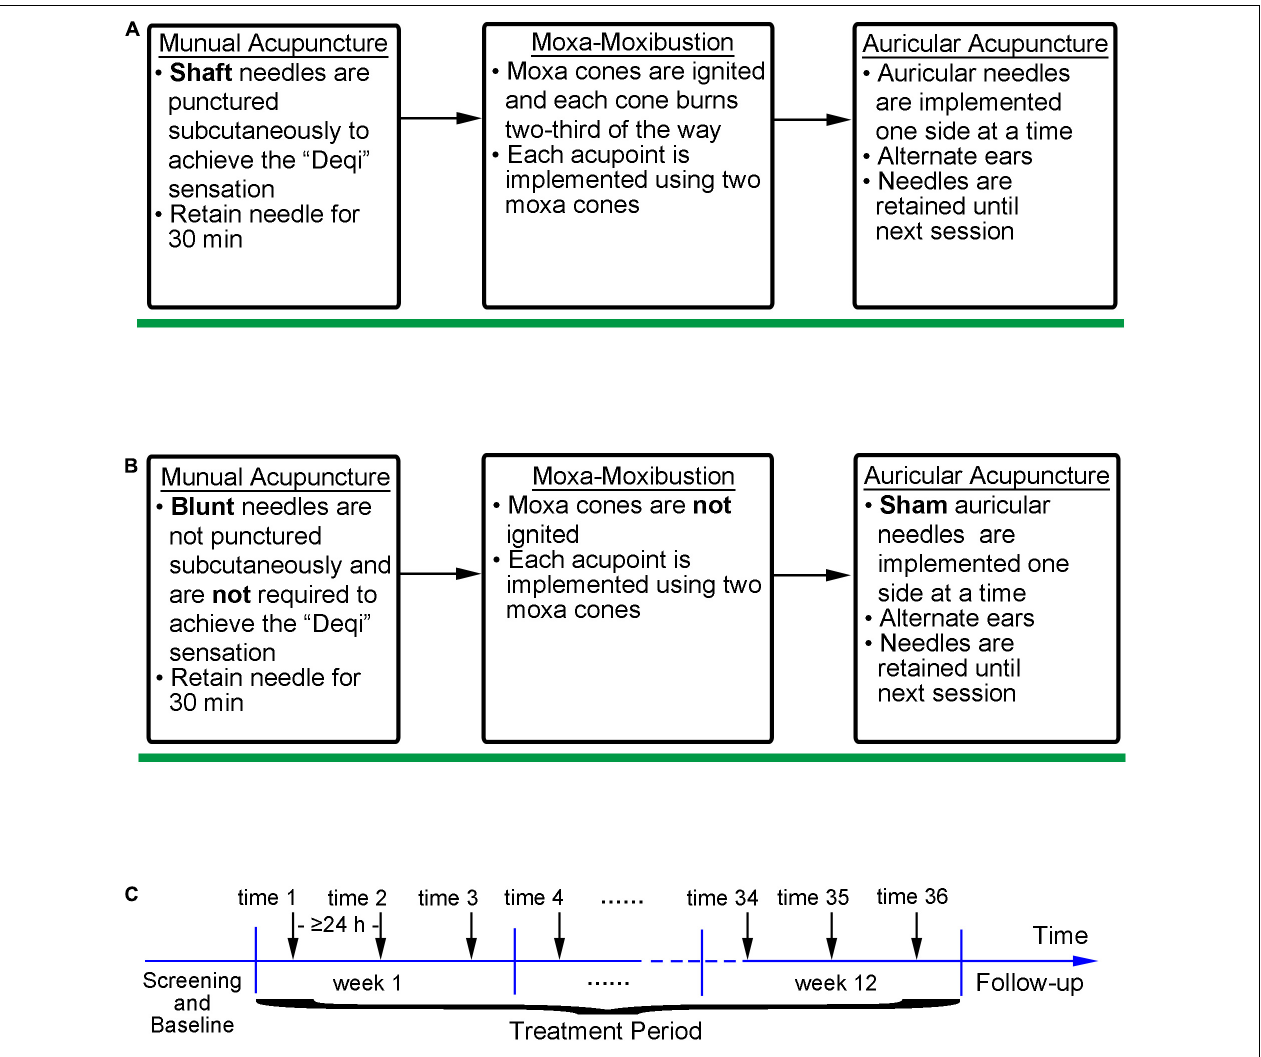
FIGURE 2 | The iAM implementation and intervention processes. (A) Implementation process of active iAM intervention; (B) Implementation process of sham iAM intervention; (C) Intervention frequency of the iAM.